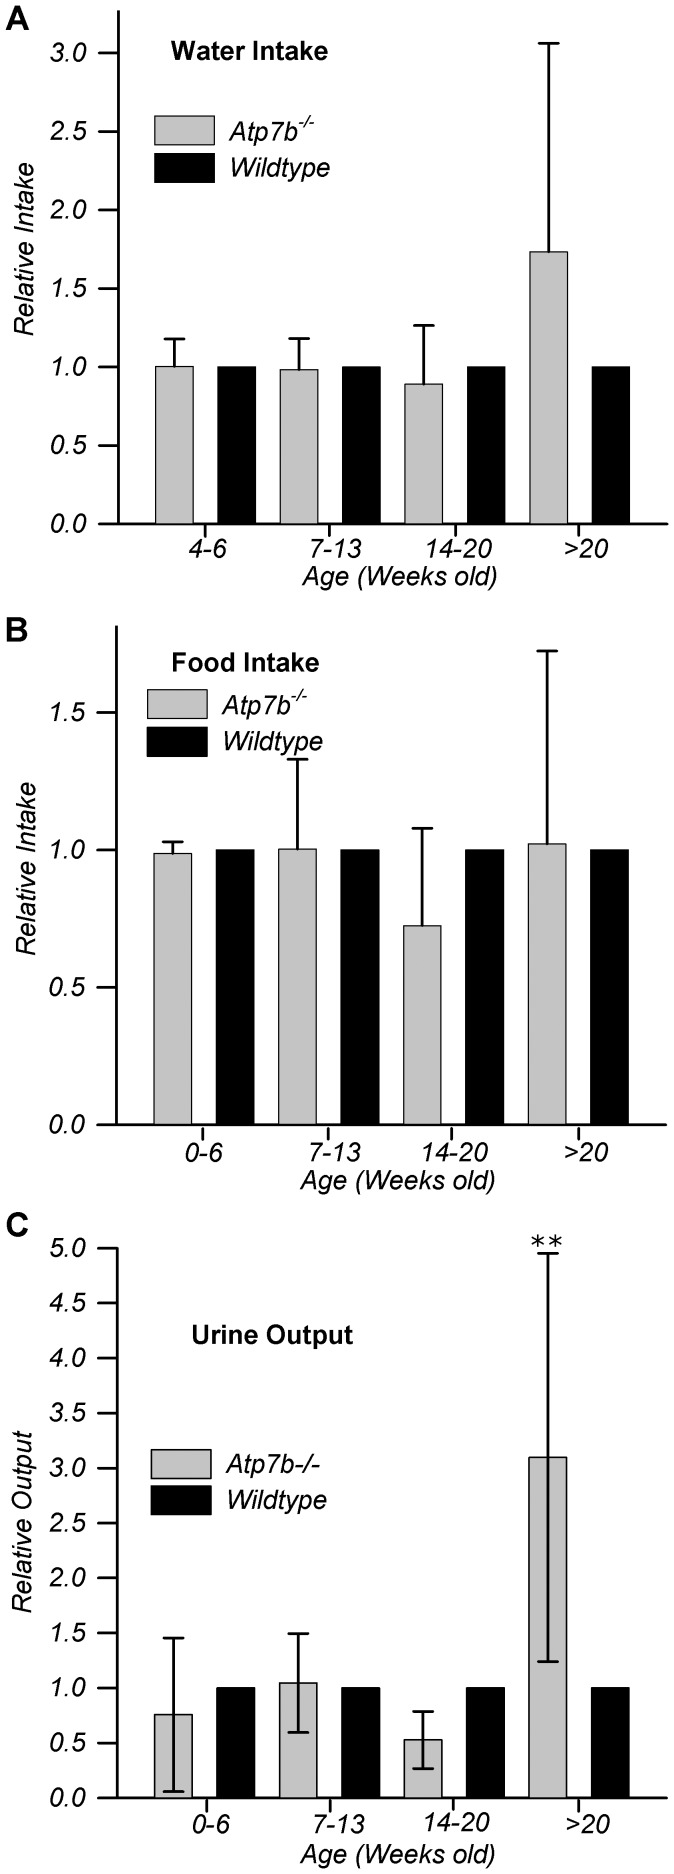
Renal function is altered in
Atp7b
−/− mice older than 20
weeks.Water intake (A), Food intake (B) and urine volume output (C) relative to
age-matched wild-type mice were measured over a 24 hr period. Double
asterisks denote p≤0.003. N = 3 to 7 age-matched
pairs; data presented as mean ± SD; additional supporting data
and details in Figure S1 and information S1.